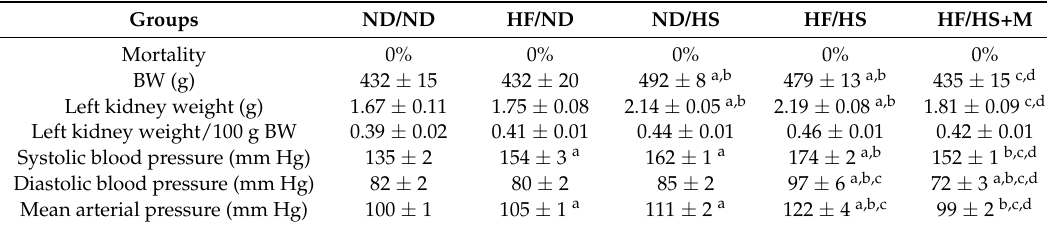
Table 1. Summary of weight, blood pressures, and functional parameters in male offspring exposed to maternal high fructose intake, post-weaning high-salt diet, and melatonin at 12 weeks of age. Groups ND/ND HF/ND ND/HS HF/HS HF/HS+M Mortality 0% 0% 0% 0% 0% BW (g) 432 ± 15 432 ± 20 492 ± 8 a,b 479 ± 13 a,b 435 ± 15 c,d Left kidney weight (g) 1.67 ± 0.11 1.75 ± 0.08 2.14 ± 0.05 a,b 2.19 ± 0.08 a,b 0.39 ± 0.02 0.41 ± 0.01 Systolic blood pressure (mm Hg) 135 ± 2 154 ± 3 a 162 ± 1 a 174 ± 2 a,b 152 ± 1 b,c,d Diastolic blood pressure (mm Hg) 82 ± 2 80 ± 2 85 ± 2 97 ± 6 a,b,c 72 ± 3 a,b,c,d Mean arterial pressure (mm Hg) 100 ± 1 105 ± 1 a 111 ± 2 a 122 ± 4 a,b,c 99 ± 2 b,c,d